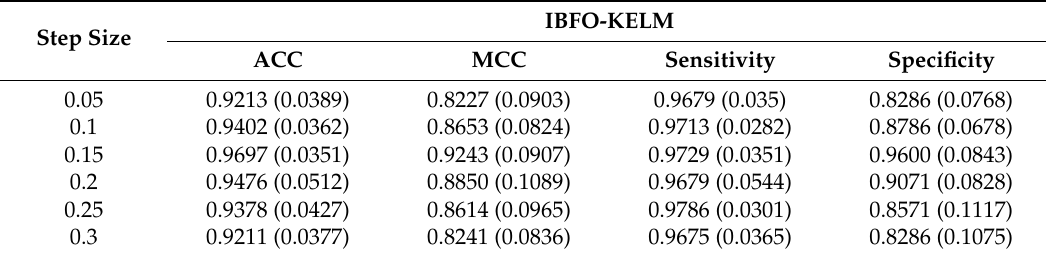
Table 4. The classification results of IBFO-KELM (kernel extreme learning machine) with different chemotaxis step size.